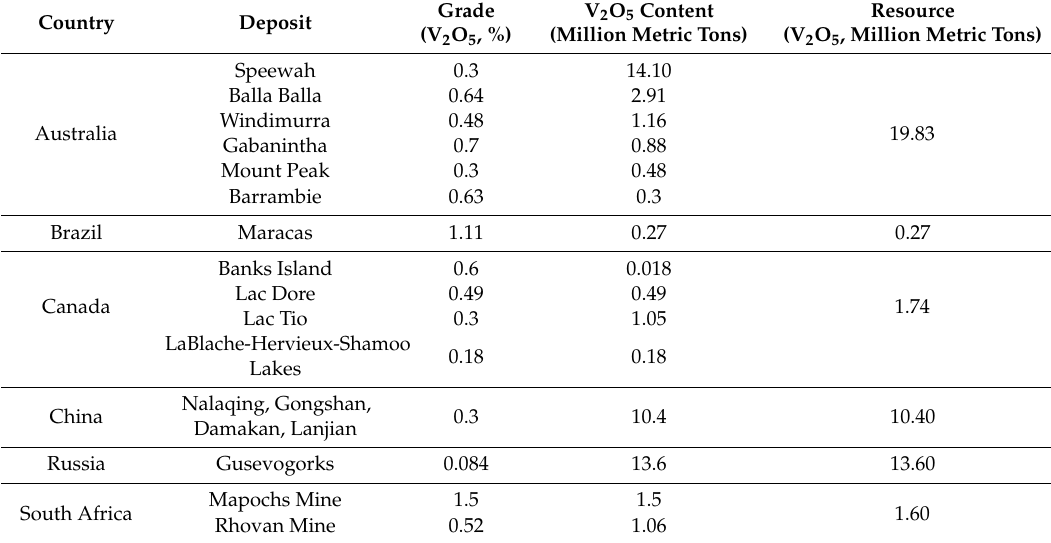
Table 1. Resource of vanadium pentoxide (V 2 O 5 ) in vanadiferous titanomagnetite (VTM) deposits [1]. Country